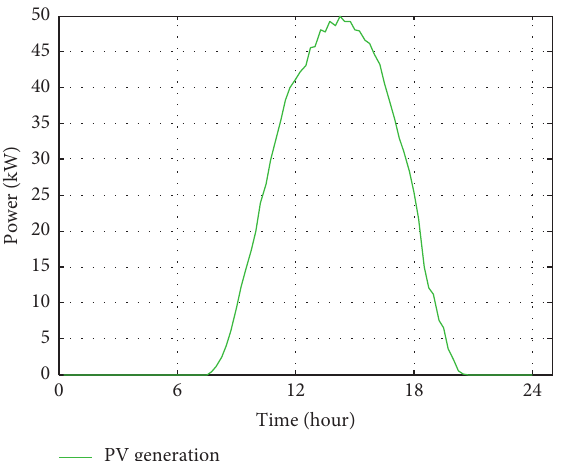
Figure 4: PV generation of a typical day.